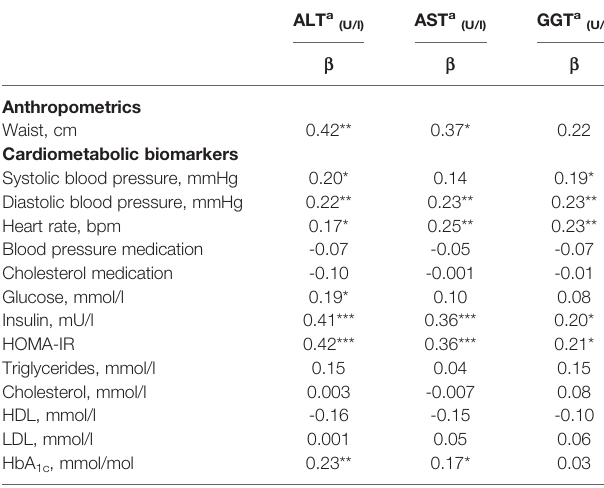
TABLE 4 | Age, sex and BMI-adjusted linear mixed regression estimates (standardized b coef fi cients) between circulating liver enzymes (ALT, AST, GGT), anthropometrics and cardiometabolic risk factors.